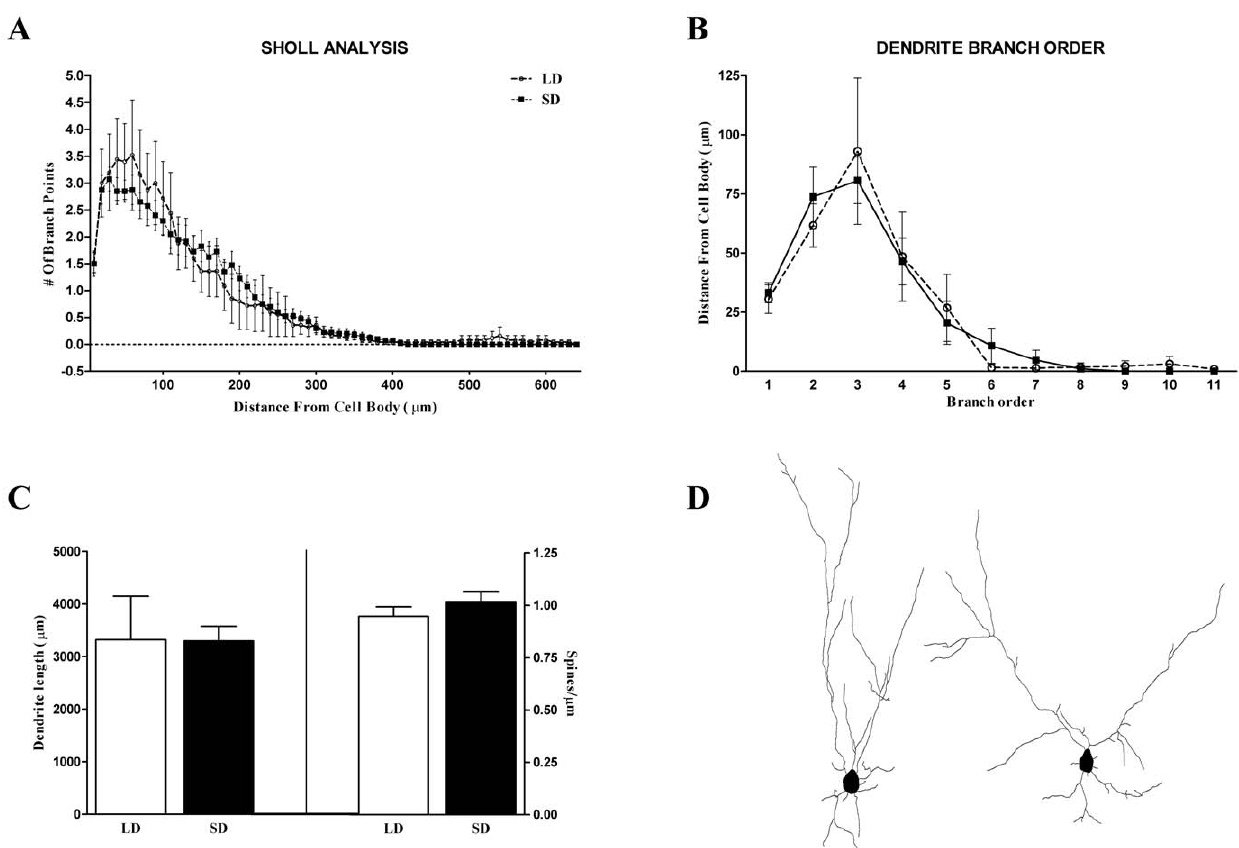
Figure 4. Olfactory bulb neuron morphology. Short day exposure did not alter dendritic intersections (A; Sholl analysis) or branch order of the dendrites (B). There were no differences due to photoperiod in dendrite length (C, left) or spine density (C, right). Representative Neurolucida tracings of olfactory bulb granule cells (D). p . 0.05 in all cases.